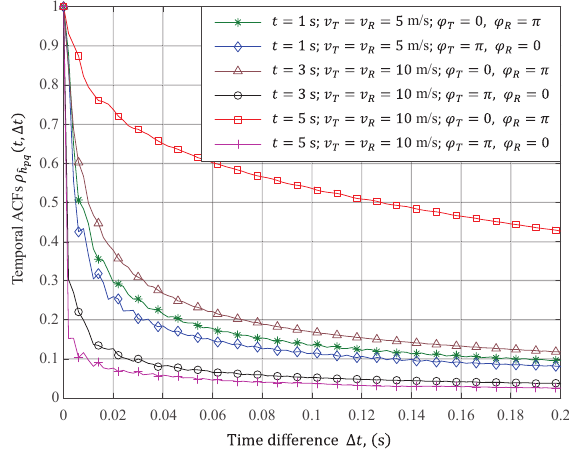
( t , ∆ t ) of non-WSSUS channel models for V2V communi- Figure 10. Estimated temporal ACFs ρ ˆ h pq cations with respect to the moving time/directions/velocities of the MT and MR when Ω = 0 and D 0 = 300 m.